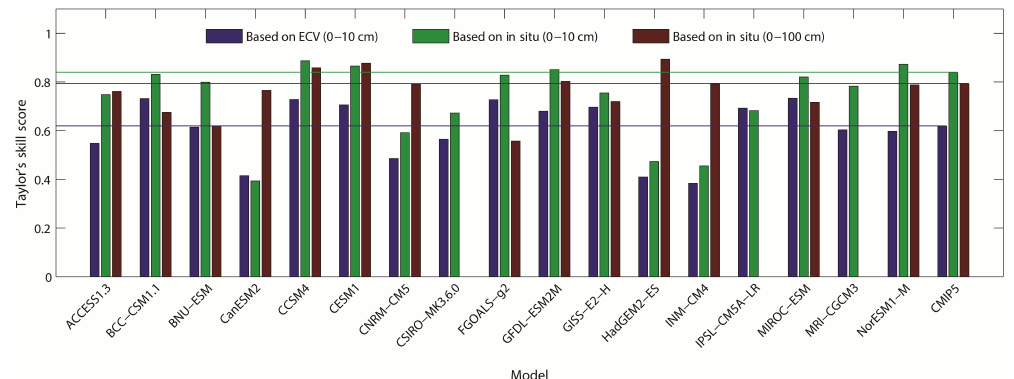
Figure 6. Taylor skill scores of CMIP5 over CONUS based on the ECV satellite data (blue) and in situ observations in the 0–10cm soil layer (green) and in 0–100cm soil moisture (brown). The solid lines indicate the skill of the CMIP5 ensemble average.